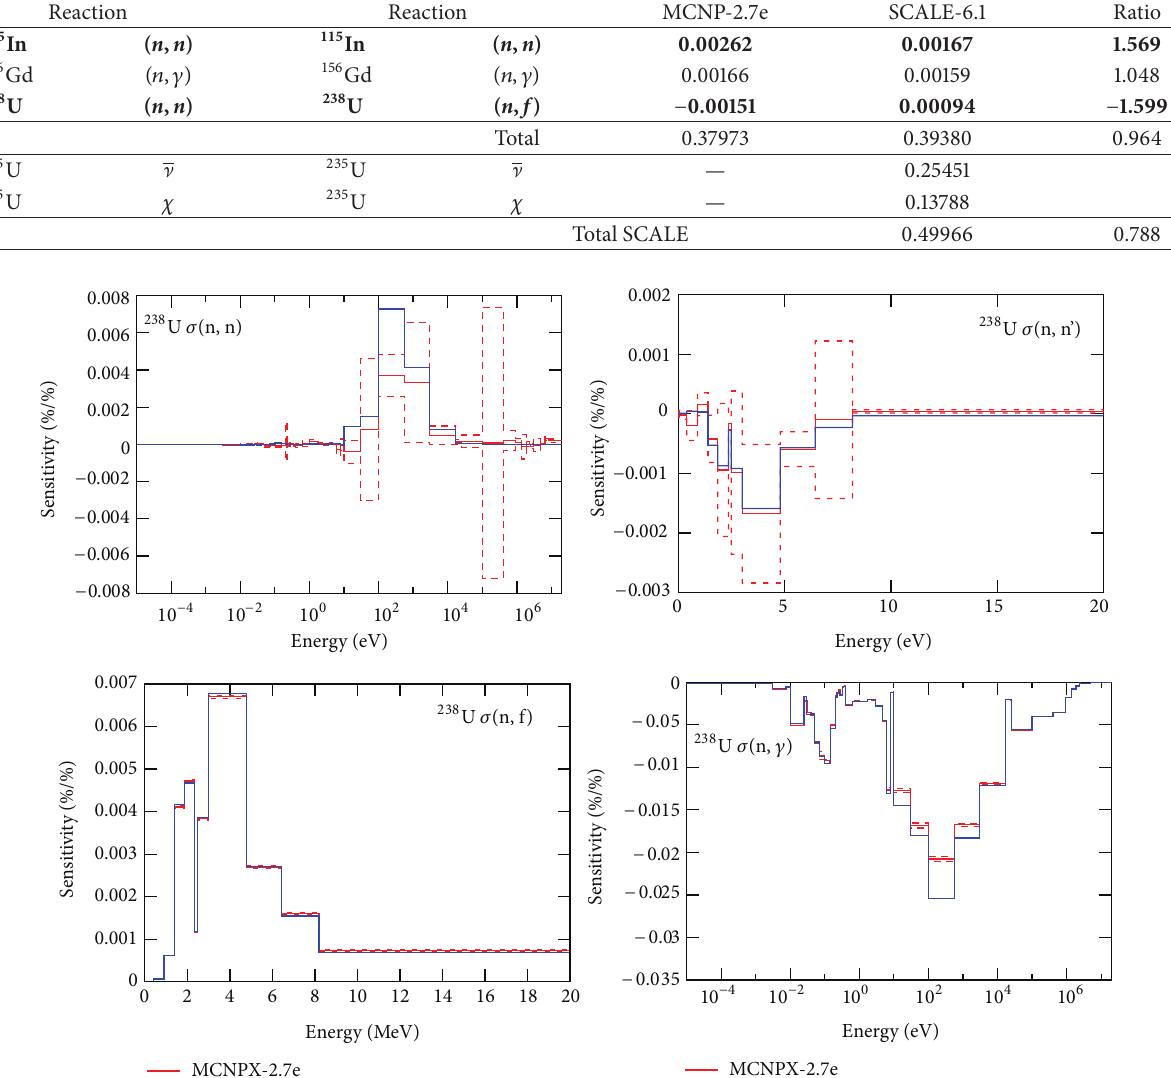
To calculate the same sensitivity coefficients as SCALE- 6.1, the keyword that sets to which reaction cross section